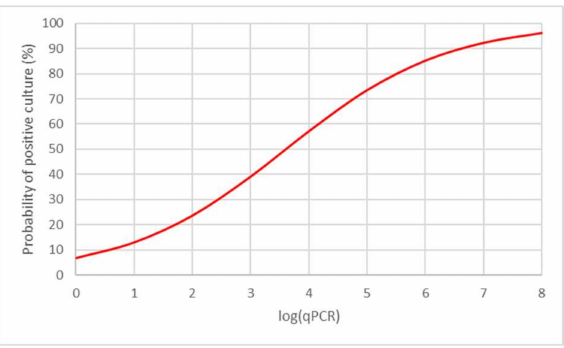
Figure 5. Probability of positive culture examination for